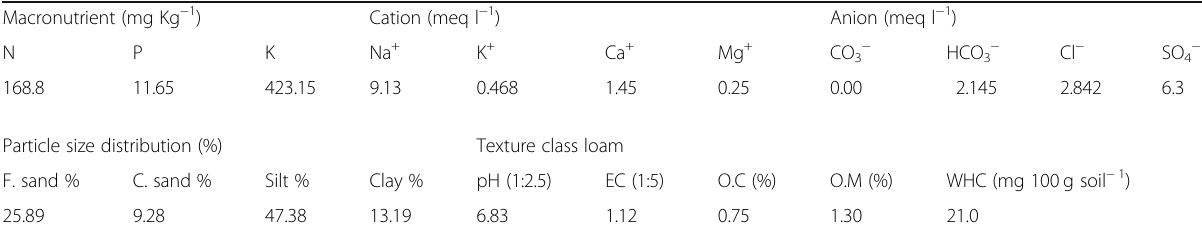
Table 1 Physical and chemical soil properties of the experimental soil Macronutrient (mg Kg − 1